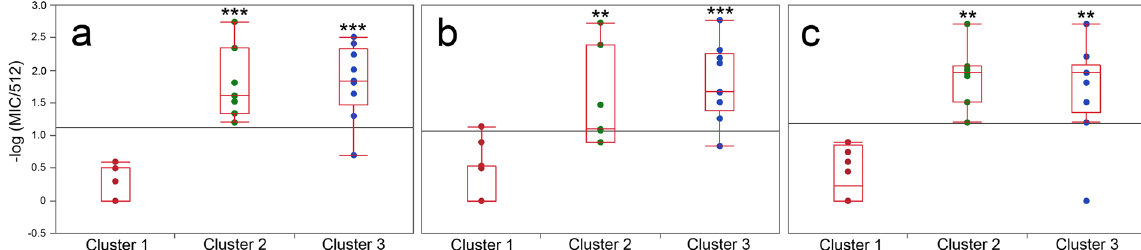
Figure 3. Peptide-induced perturbation of the main phase transition of model membranes is correlated to broad and potent antimicrobial activity. Minimum inhibitory concentration (MIC) assays were performed in biological triplicates for evaluated peptides (Supplementary dataset 01). MIC data were transformed to -log(MIC/512) and used to create a box plot as a function of peptide clusters obtained from the multivariate statistical analyses (Table 2). Microorganism classes were ( a ). Gram-positive bacteria, ( b ). Gram-negative bacteria, and ( c ). Yeasts. Please see text for a detailed description of the evaluated microorganisms. The Steel- Dwass all pairs statistical test was applied ( ** p < 0.01 or *** p < 0.001). Asterisks denote statistical difference of given clusters in relation to cluster 1. Horizontal grey lines correspond to the grand mean.